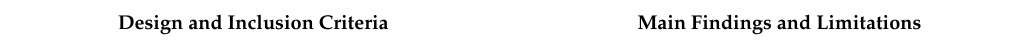
Table 3. Overview of selected studies on eCPR alone or as a part of a combined hyperinvasive approach vs. conventional manual chest